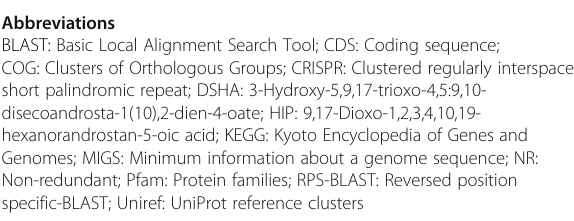
Additional file 1: Table S1. Genes associated with steroid metabolism. (XLSX 14 kb)